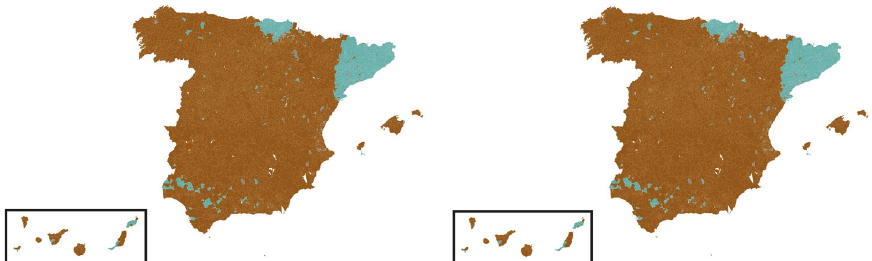
Figure 18: Focusing on the bimodal distribution for the conservative party that emerges in the heat map of Figure 16, here we show in a spatial map of Spain where we assign a brown color to those municipalities that belong to the larger cluster (high vote share) and a turquoise color to those that belong to the smaller cluster (low vote share). We find that the low vote share clusters are predominantly linked with Catalonia and the Basque Country, the two areas of Spain with some proindependence aspirations. No obvious change is perceived between 2015 and